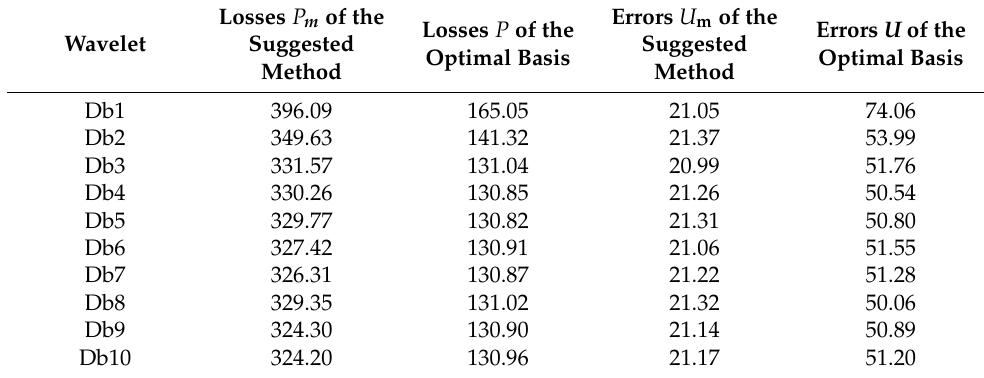
Table 1. Method efficiency estimate results, obtained from the data for January 2021.